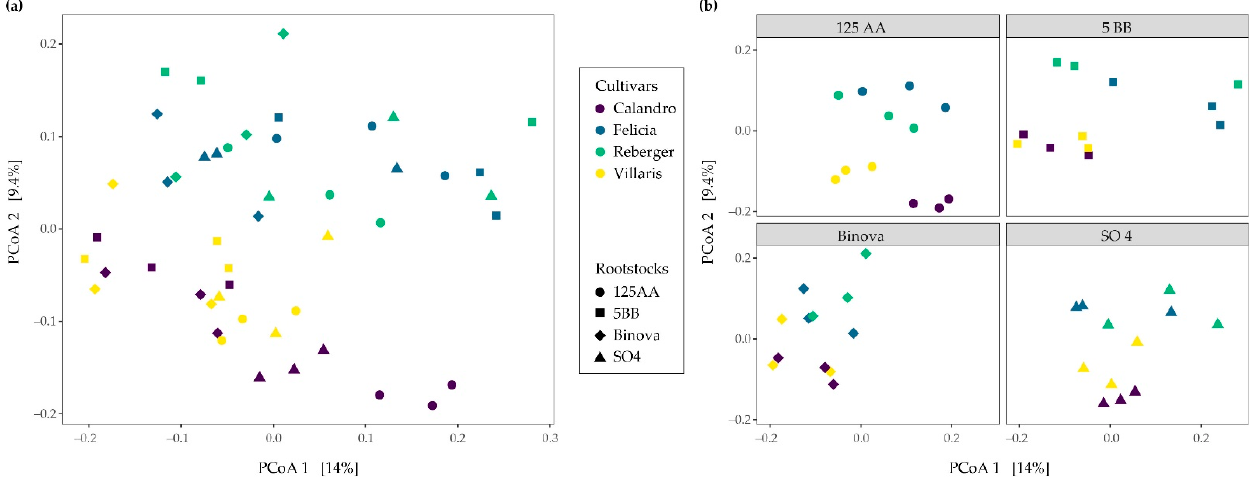
Figure 2. PCoA of rhizosphere soil bacterial communities based on the Bray-Curtis dissimilarities. The figure displays ( a ) collection of all samples or ( b ) plots separated according to each rootstock.